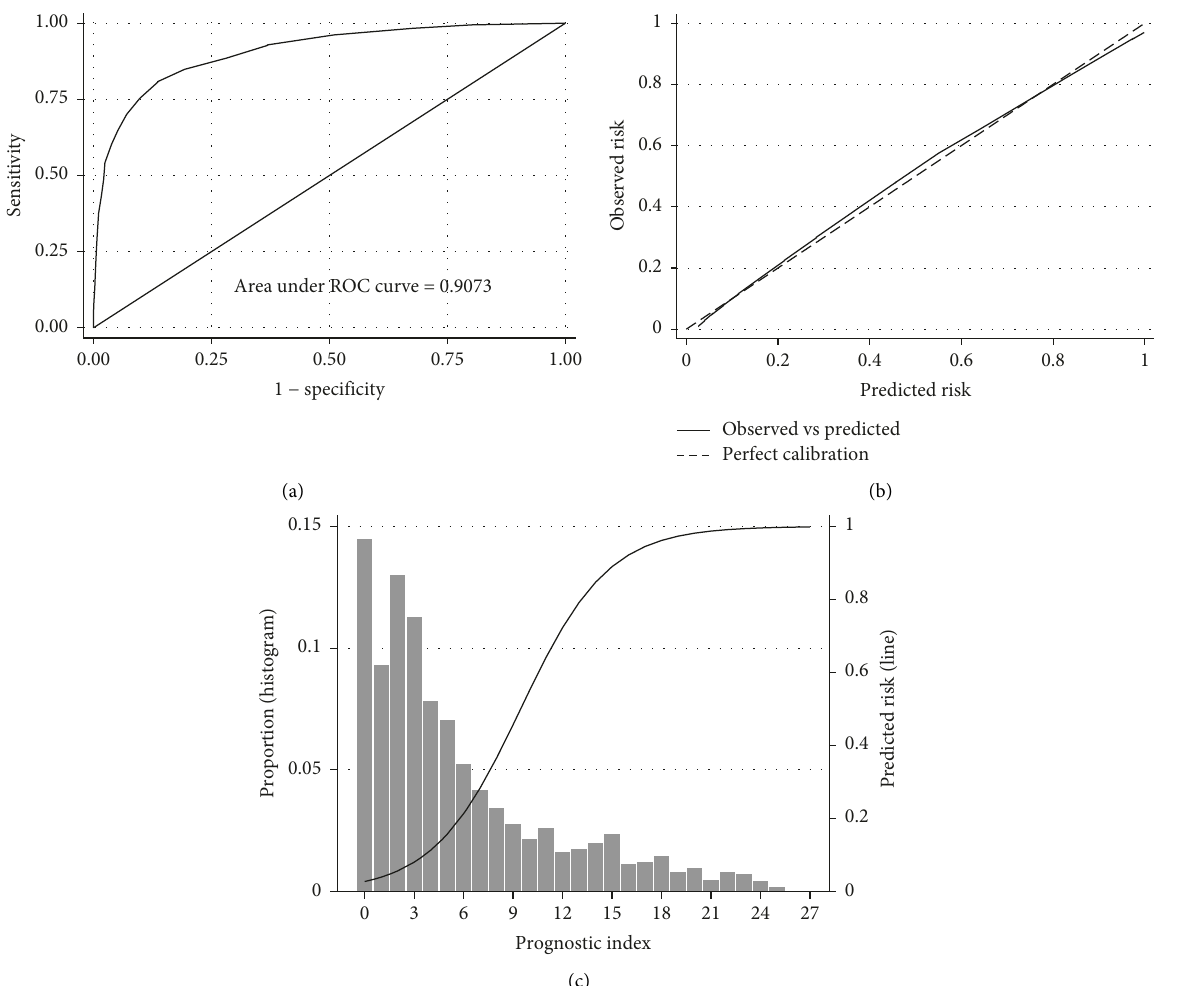
Figure 2: Discrimination (a), calibration (b), distribution of cases (c), and predicted probability of death or hypoxaemia (lower panel line) of the predictive model in the validation